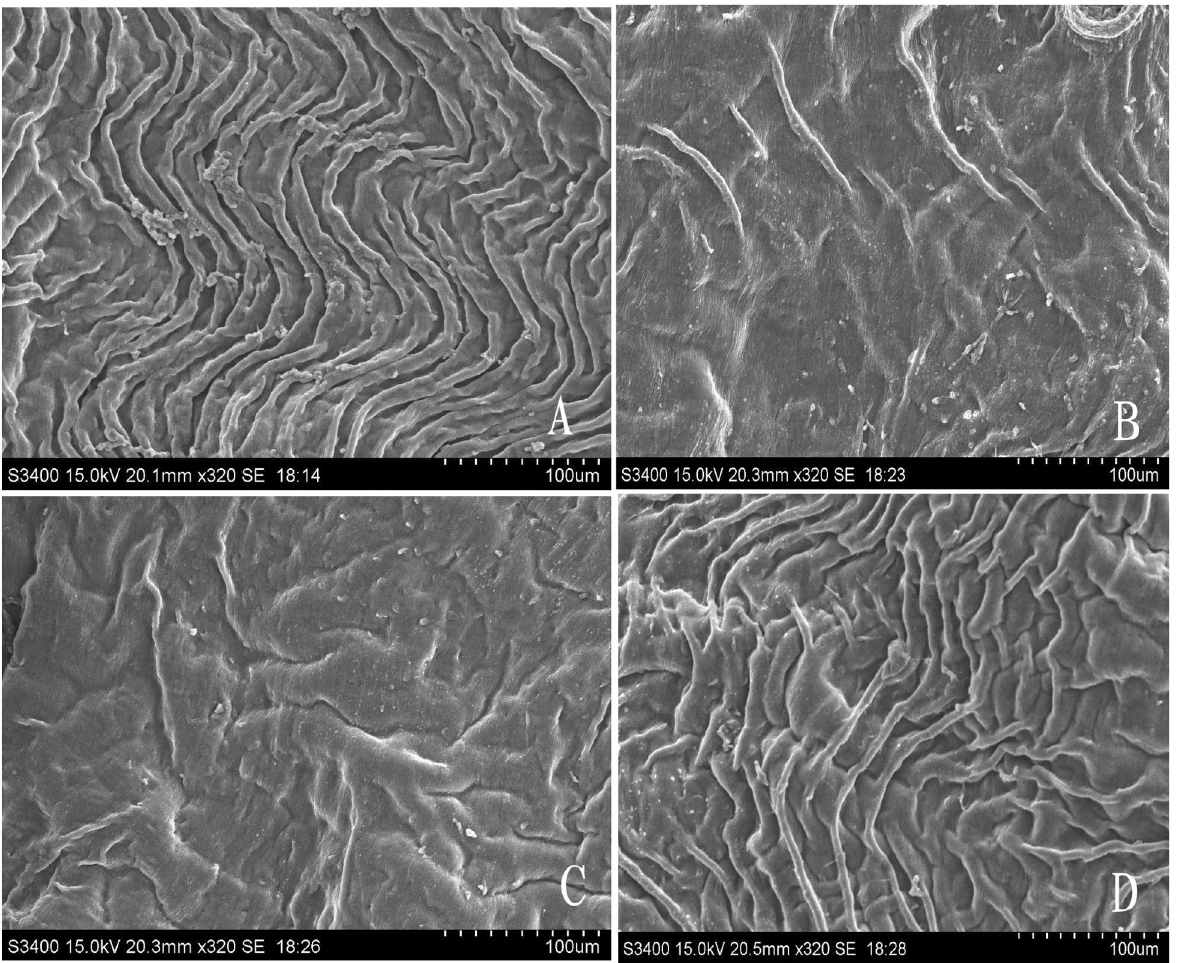
Figure 6. Scanning electron microscopy (SEM) images of the aortic arch wall. Groups of C57BL/6J mice (3 mice per group) were im- munized ip with PBS, HUVECs, HUVECs+CRM197, and CRM197 over 4 consecutive weeks, 1 week after the last immunization. Mice were then sacrificed and their aortas were harvested and opened. Direct observation of endothelial damage in arterial walls by SEM (original magnification: 450X) showed that vaccination with viable HUVECs (B) and HUVECs+CRM197 (C) caused profound altera- tions in the aortic tissue structure. However, the aorta from the PBS (A) and CRM197 (D) groups maintained their regular aortic plica. HUVECs = human umbilical vein endothelial cells; CRM197 = nontoxic diphtheria